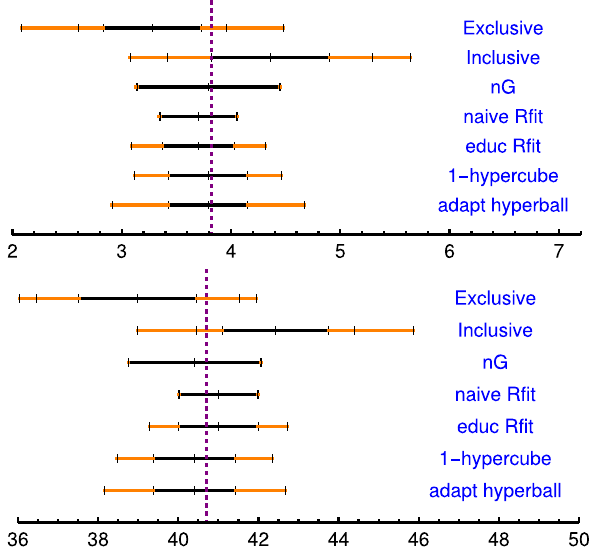
Fig. 14 Top inclusiveandexclusiveinputsfortheCKMmatrixelement | V | (times 10 3 ) and the averages resulting from the different models ub considered here. Bottom same for the determinations of | V cb | (times 10 3 ) CKM matrix element. The intervals are given at 3 σ . See Fig. 12 for the